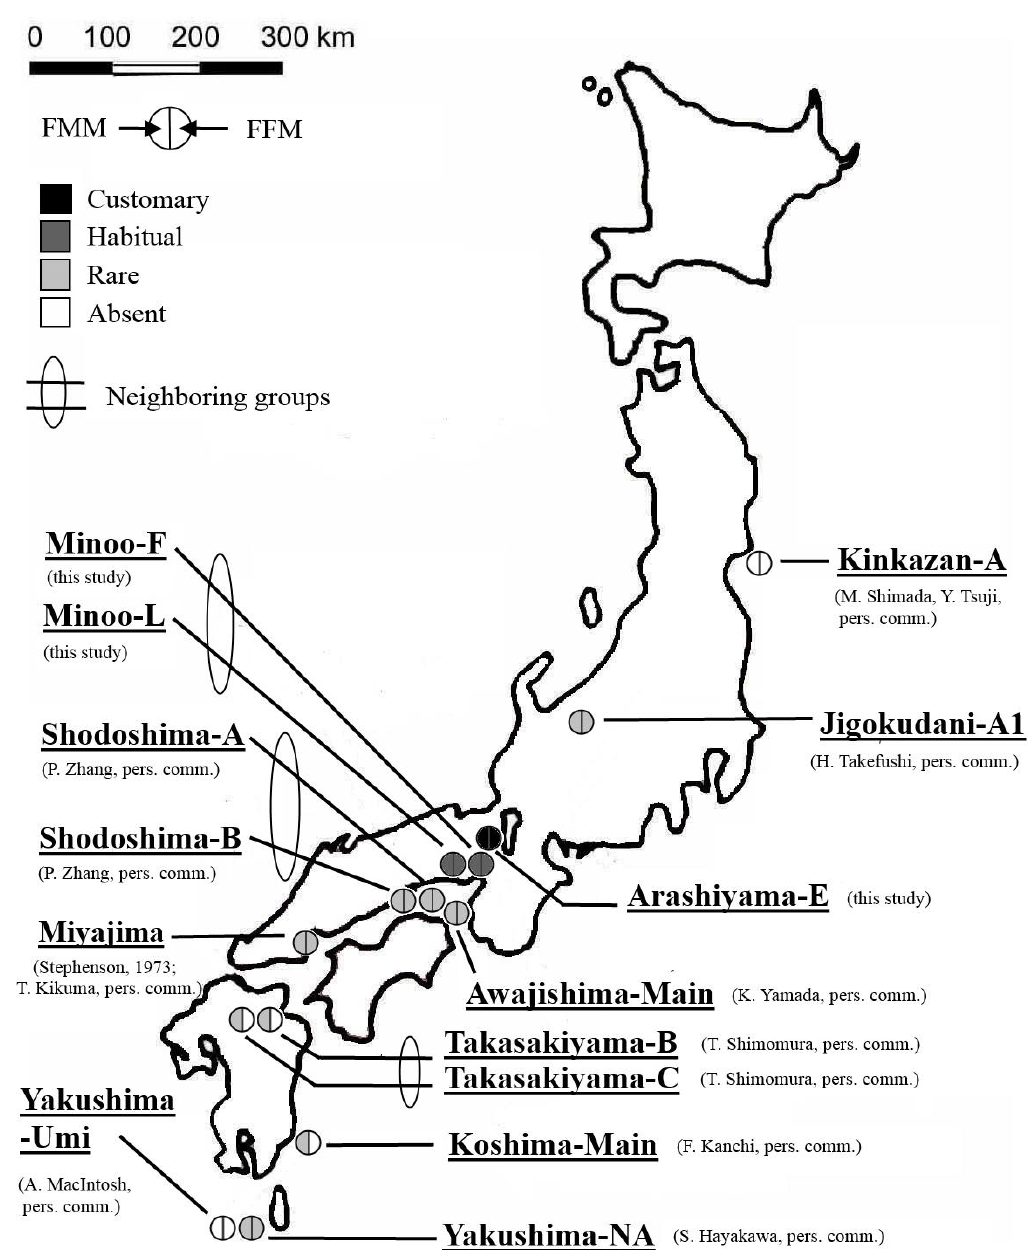
Figure 1. Map of Japan and inter-group comparison of FMM and FFM frequencies assessed by ordinal data collected during this study and complemented with a questionnaire-based survey conducted on researchers and Monkey Park staff with several years of observation during the mating season (Absent: not observed, Rare: observed from one to three times, Habitual: FMM observed from 15 to 50 times and FFM observed from 15 to 150 times, Customary: FMM observed more than 50 times and FFM observed more than 150 times; all frequency categories over at least 75h of observation and weighted by the number of group members developmentally capable to engage in FMM and